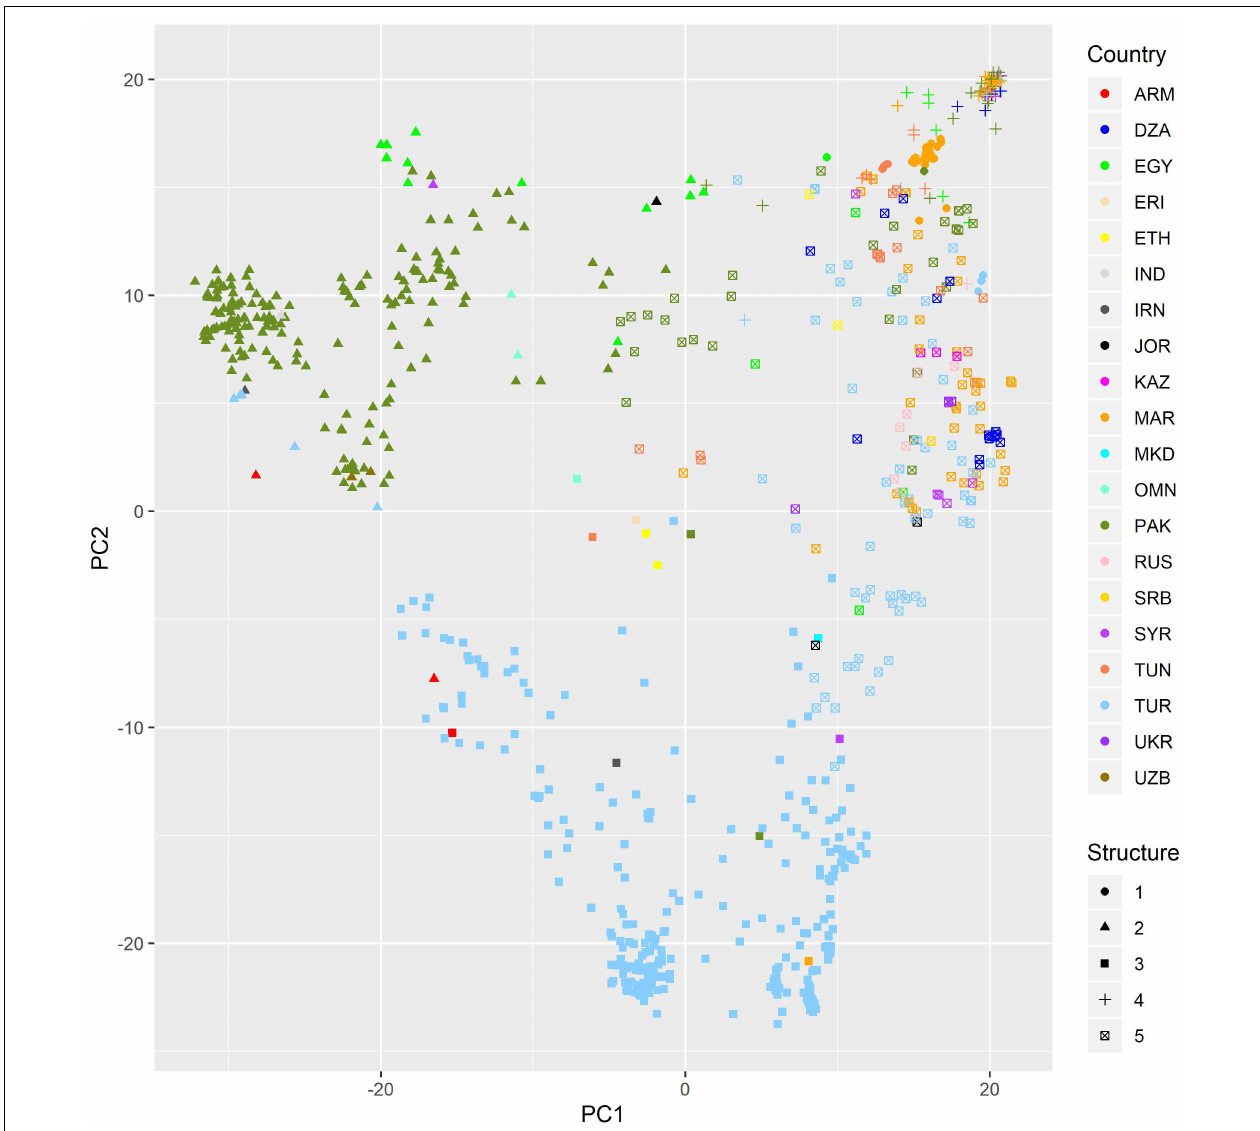
FIGURE 1 | PC plot of a set of bread wheat landraces from PCA using DarTseq markers. Colorsed by country of origin. Dot shape gives the assignment to subpopulations when K = 5.